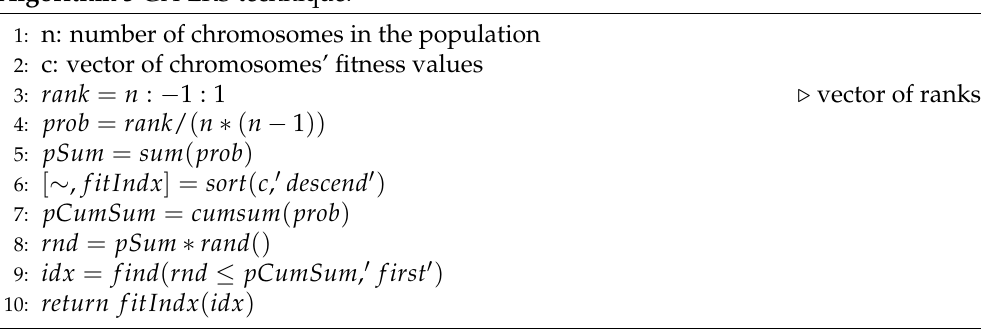
Algorithm 3 GA LRS technique.